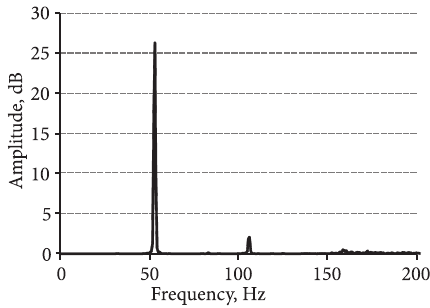
fig. 2. Frequency spectrum of the vibratory drum during hot-mix asphalt compaction (Micaelo